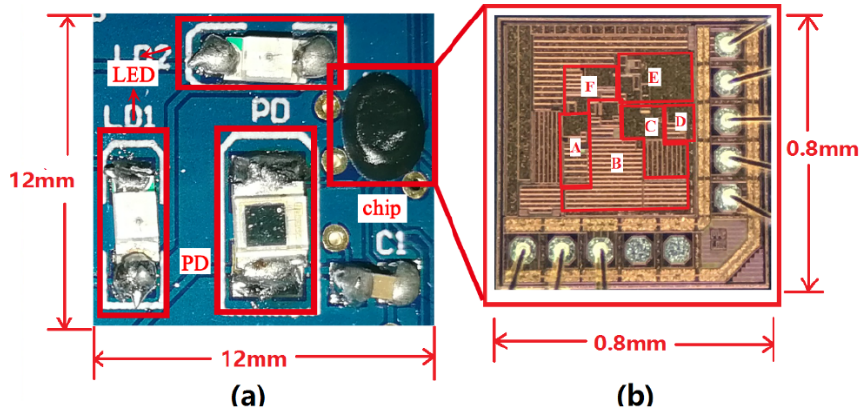
Figure 10. The testing board ( a ) and micrograph of the die ( b ), including TIA (A), SA (B), LPF (C), buffer (D), biasing (E) and AGC (F).